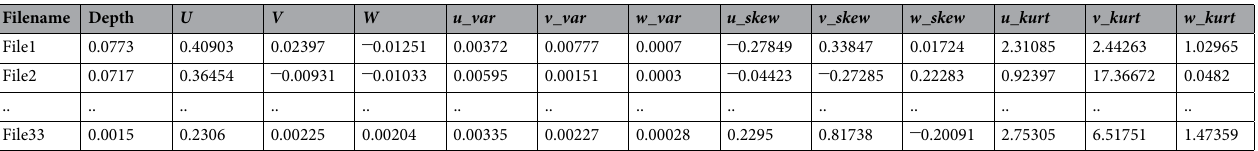
Table 5. Statistical parameters of turbulence obtained via